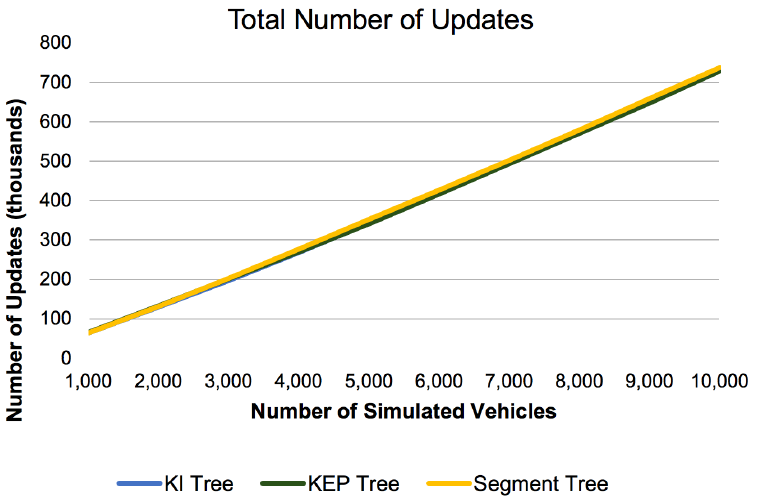
Figure 19. Total Number of Updates